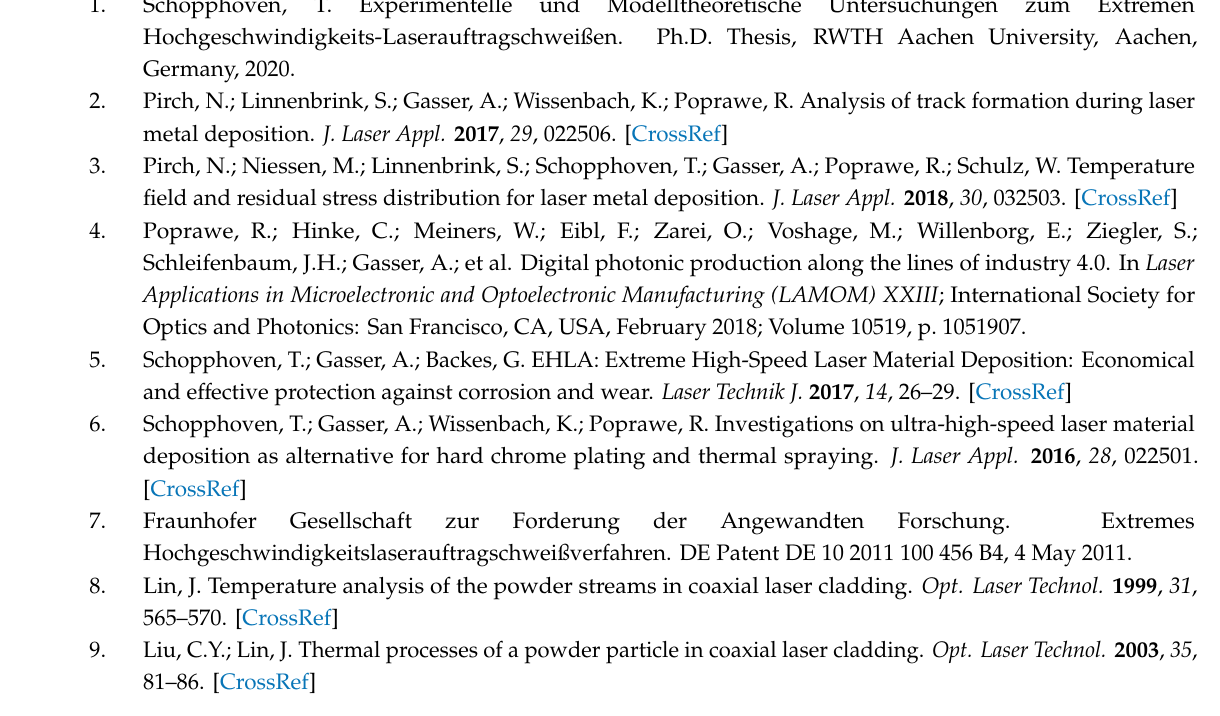
Figure 12. Diagram of the partial overlap in the x-y plane within a single image in level E4. Parameters: grain fraction − 53 + 20 µm, 𝑚(cid:4662) (cid:3043) = 5 g/min, V FG = 5 L/min, V SG = 10 L/min [1]. Reprinted with permission from Ref [1]. Copyright 2020, Fraunhofer Verlag.